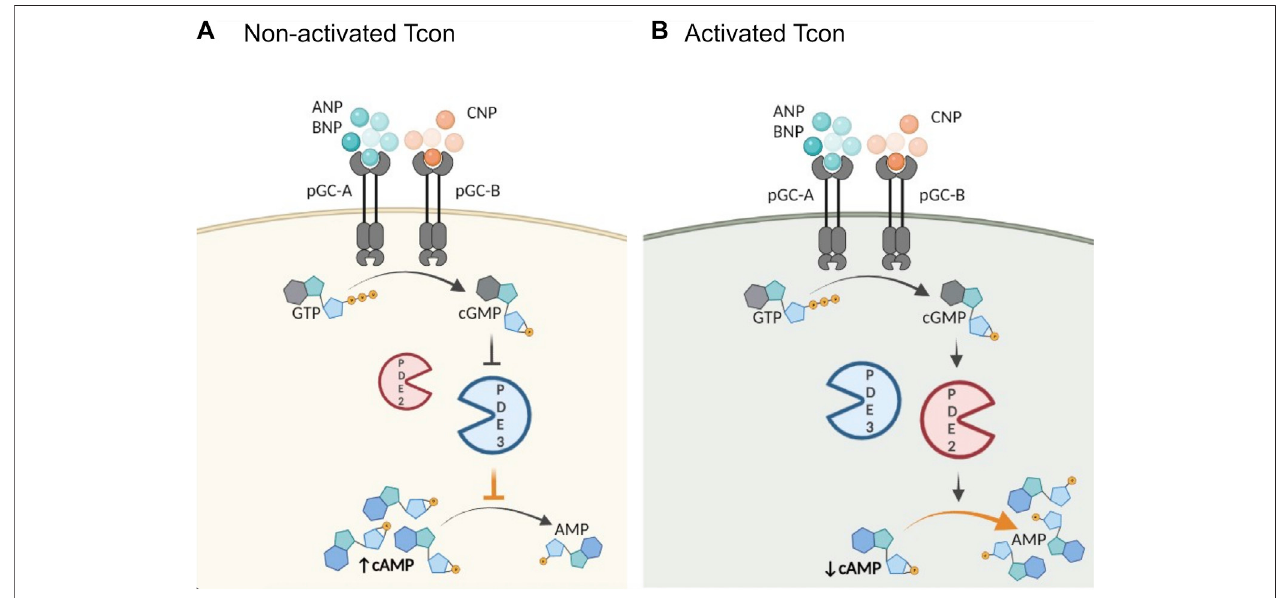
FIGURE 5 | Schematic illustration of proposed role of activation and PDE2A in the cGMP/cAMP cross-talk in Tcon. cGMP generation is catalyzed by particulate GCs (pGC), membrane receptors for natriuretic peptides (NP). Central PDEs in the cross-talk are PDE2A and PDE3. (A) In non-activated Tcon, cGMP binds predominantly to PDE3 and acts as a competitive inhibitor of cAMP hydrolysis resulting in a positive cGMP/cAMP cross-talk loop, thereby increasing intracellular cAMP levels, while (B) PDE2A upregulation in activated Tcon shifts the balance to a negative cGMP/cAMP cross-talk. PDE2A is known as a dual-substrate enzyme hydrolyzing both cyclic nucleotides. Binding of cGMP to the GAF-B domain of PDE2A initiates negative cGMP/cAMP cross-talk and cAMP hydrolysis occurs at higher rate, resulting in a net decrease of intracellular cAMP. Schematic illustration was made using BioRender.